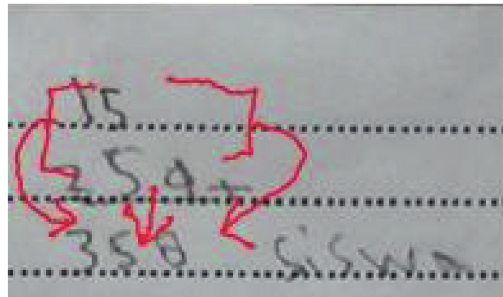
Figure 6: Answer of student who does not understand the place value in short-complex addition.